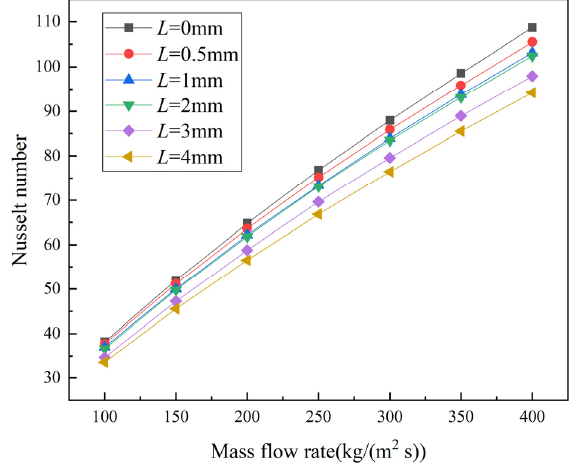
Figure 8. Nusselt number values of PCHEs at different mass flow rates for different offset distances of inserted straight sections.